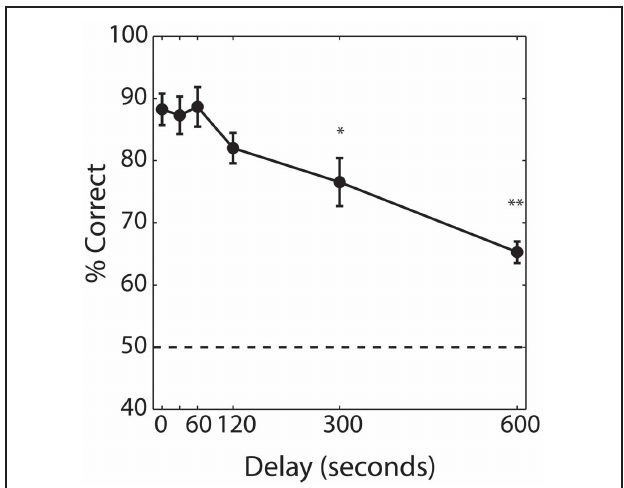
FIGURE 3 | Performance on the baseline delayed match-to-sample. Percent correct performance as a function of delay, averaged across subjects ( n = 6). Error bars indicate ± 1 SEM. Asterisks indicates significant differences of ∗ P < 0 . 05 and ∗∗ P < 0 . 001 from performance obtained with a 0s delay (baseline memory test).